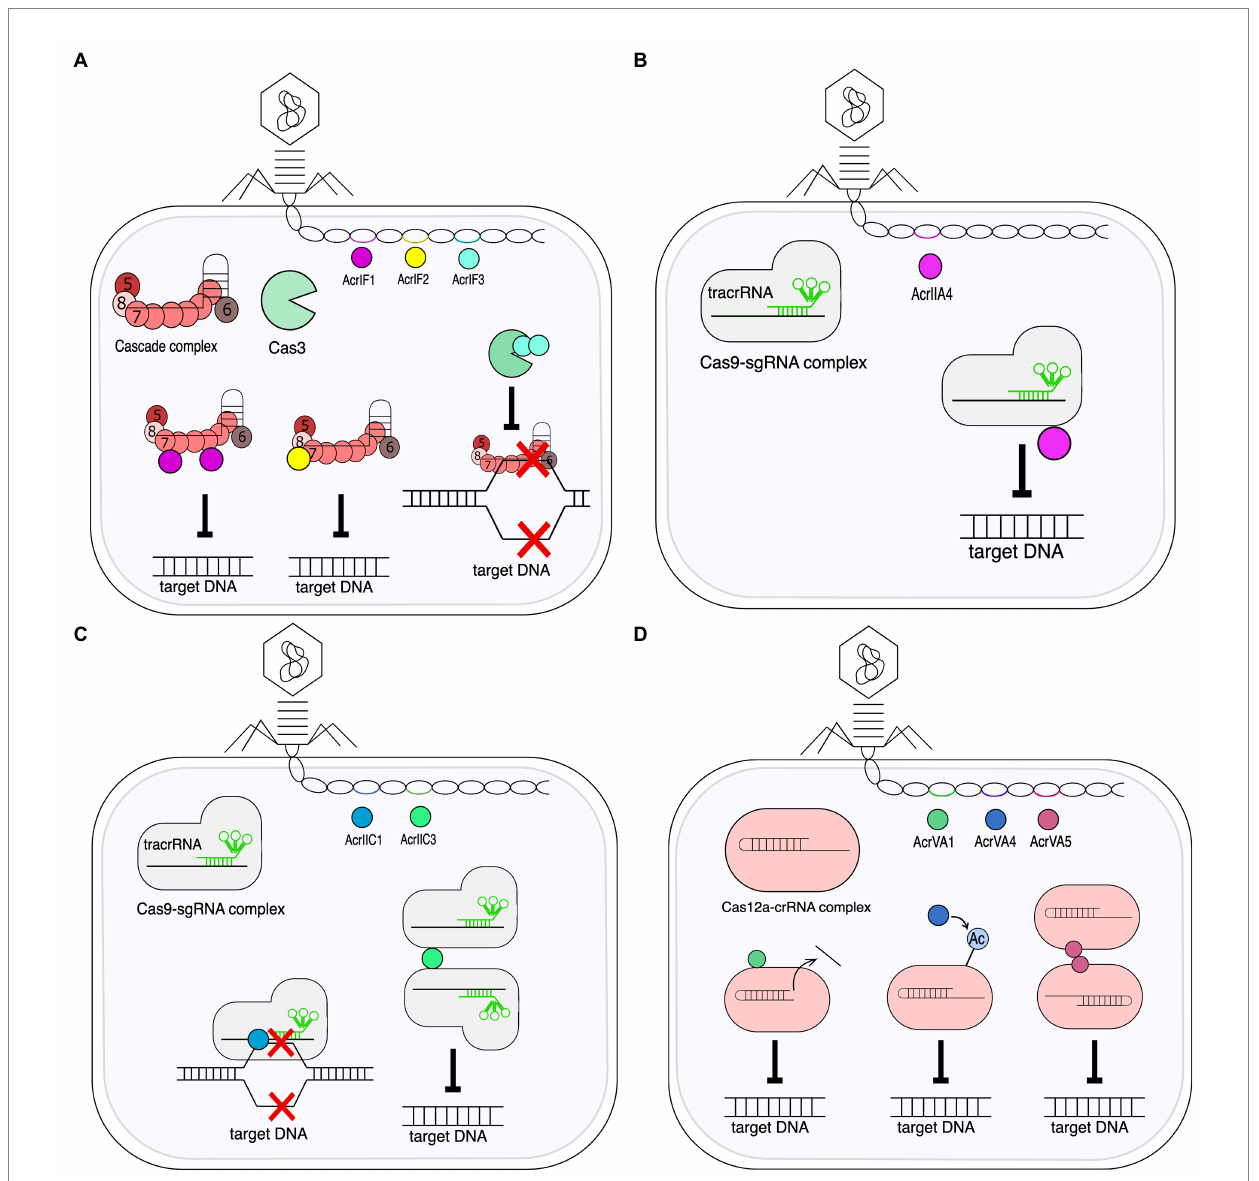
FIGURE 5 Mechanisms of action of Acr proteins. (A) Mechanism of AcrVA1, AcrVA4, AcrVA5. AcrVA4 and AcrVA5 inhibit double stranded DNA recognition. AcrVA4 dimerizes the Cas12a-crRNA complexes, and the AcrVA5 protein acylates a Cas12 lysine residue that interacts with the PAM motif. AcrVA1 cuts the 3 ′ end of the crRNA and thus prevents recognition of the protospacer. (B) Mechanism of AcrIIA4. The AcrIIA4 protein mimics double stranded DNA and blocks target DNA recognition by binding to the Cas9-sgRNA complex. (C) Mechanism of AcrIIC1 and AcrIIC3. The AcrIIC1 protein binds to the HNH domain of the Cas9 endonuclease, thereby disrupting its nucleolytic activity and preventing cleavage target DNA. The AcrIIC3 protein, on the other hand, blocks binding to the target DNA by inducing Cas9 dimerization. (D) Mechanism of AcrIF1, AcrIF2, and AcrIF3. AcrIF1 by attaching to the Cascade complex (Cas7) inhibits binding to the target DNA. By binding to the complex at different sites (Cas8 and Cas7), the AcrIF2 protein also blocks binding to exogenous DNA. In contrast, the AcrIF3 protein binds to Cas3 nuclease and prevents cleavage the target